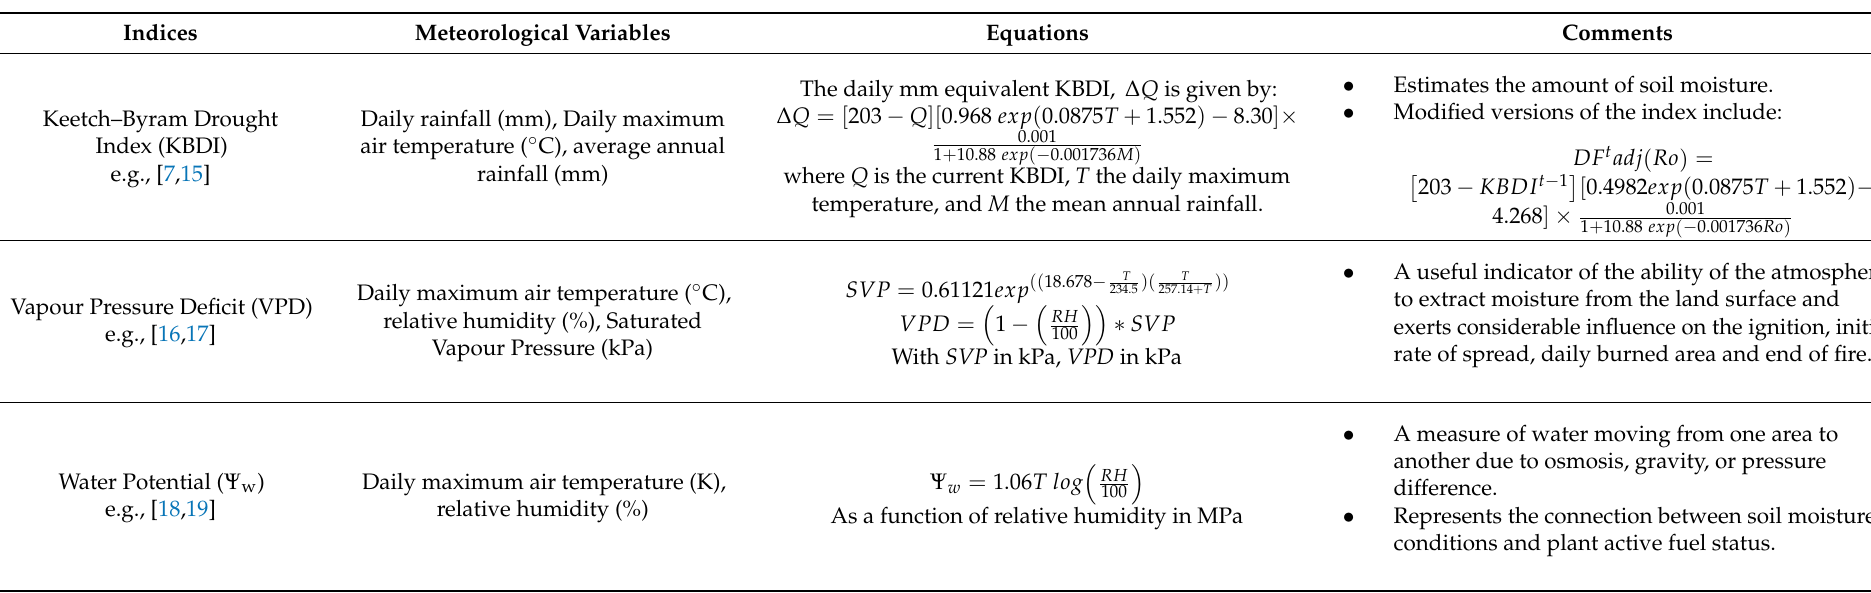
Table 1. Summary of fire potential indices used in this study including the meteorological variables and equations used for their